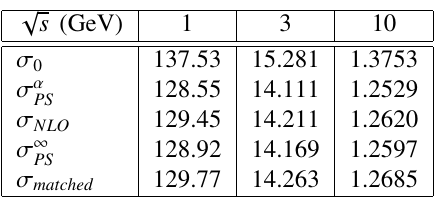
Table 2. Photon pair production cross sections (in nb) to di ff erent accuracy levels (from Ref. [3], see there for